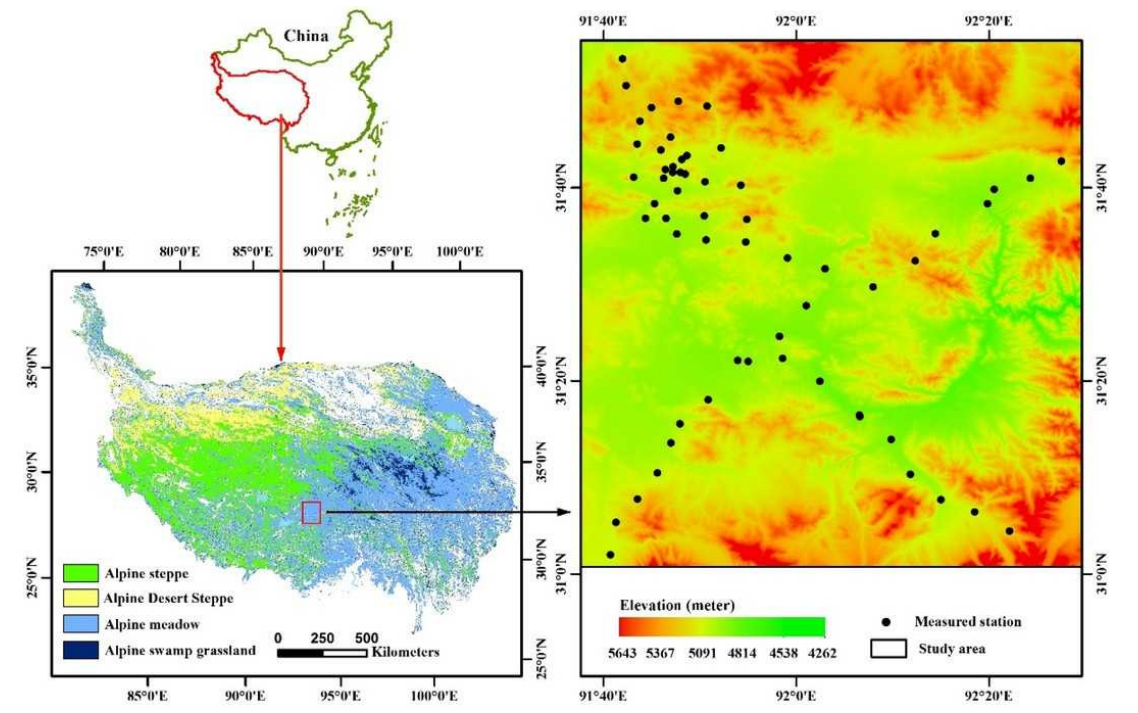
Figure 1. Naqu network location in CTP-SMTMN, the station geographical distribution. Figure adapted from